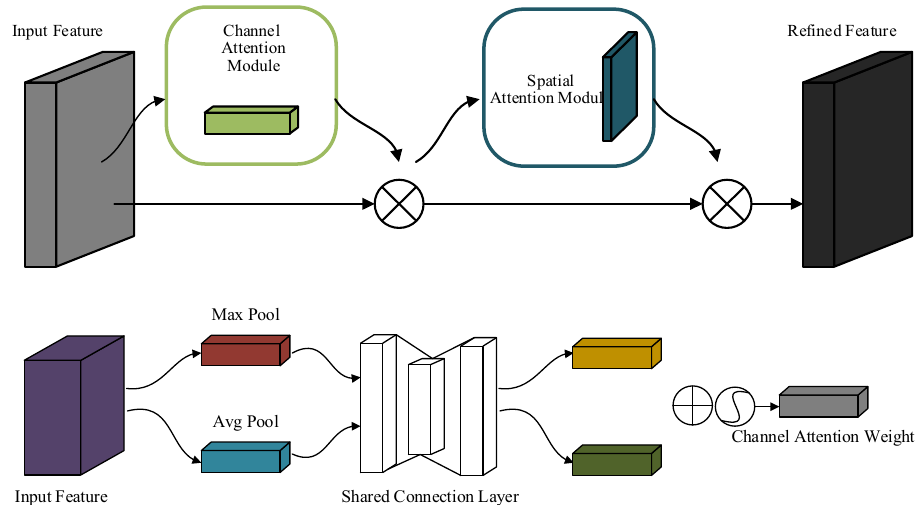
Fig. 4 The channel attention